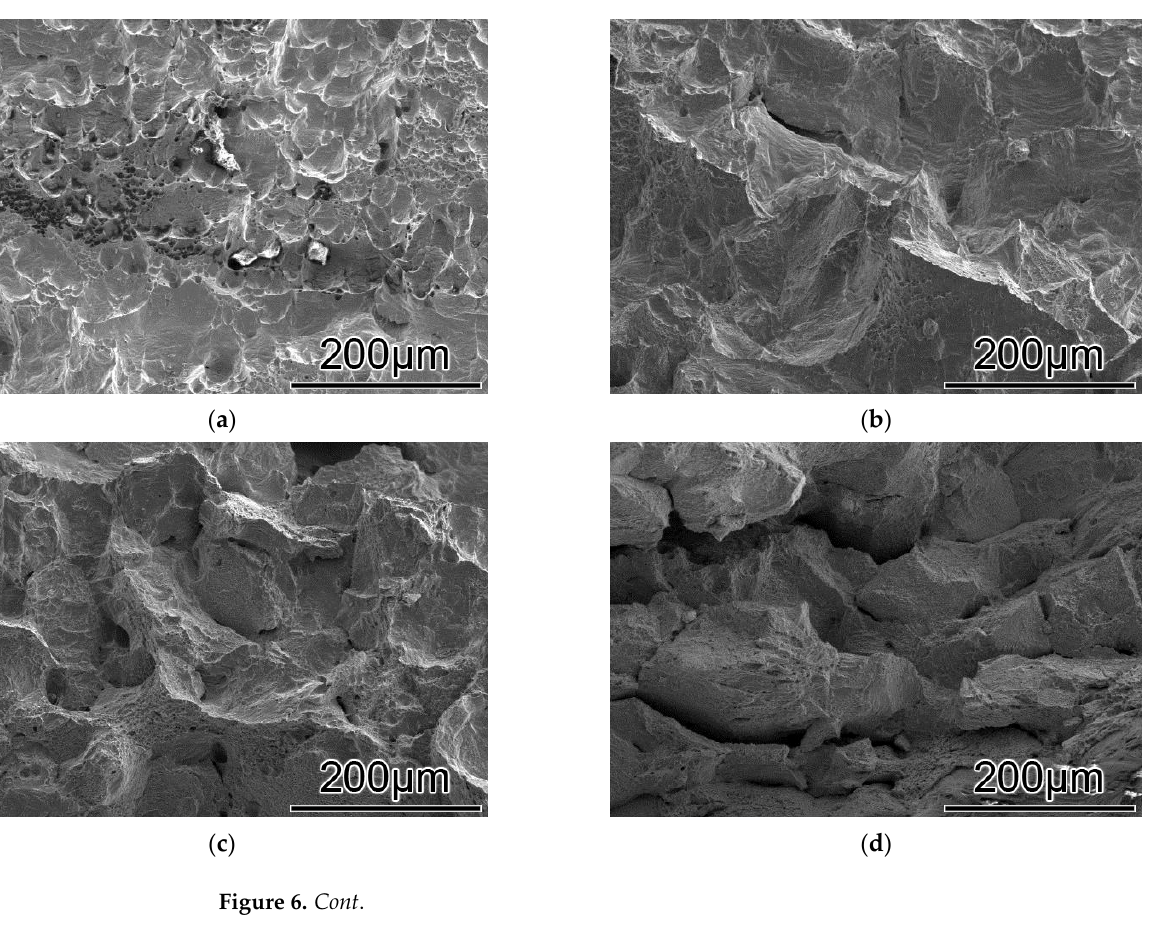
Figure 5. Charpy impact and hardness test result of 316 LNSS at 750 °C aging.